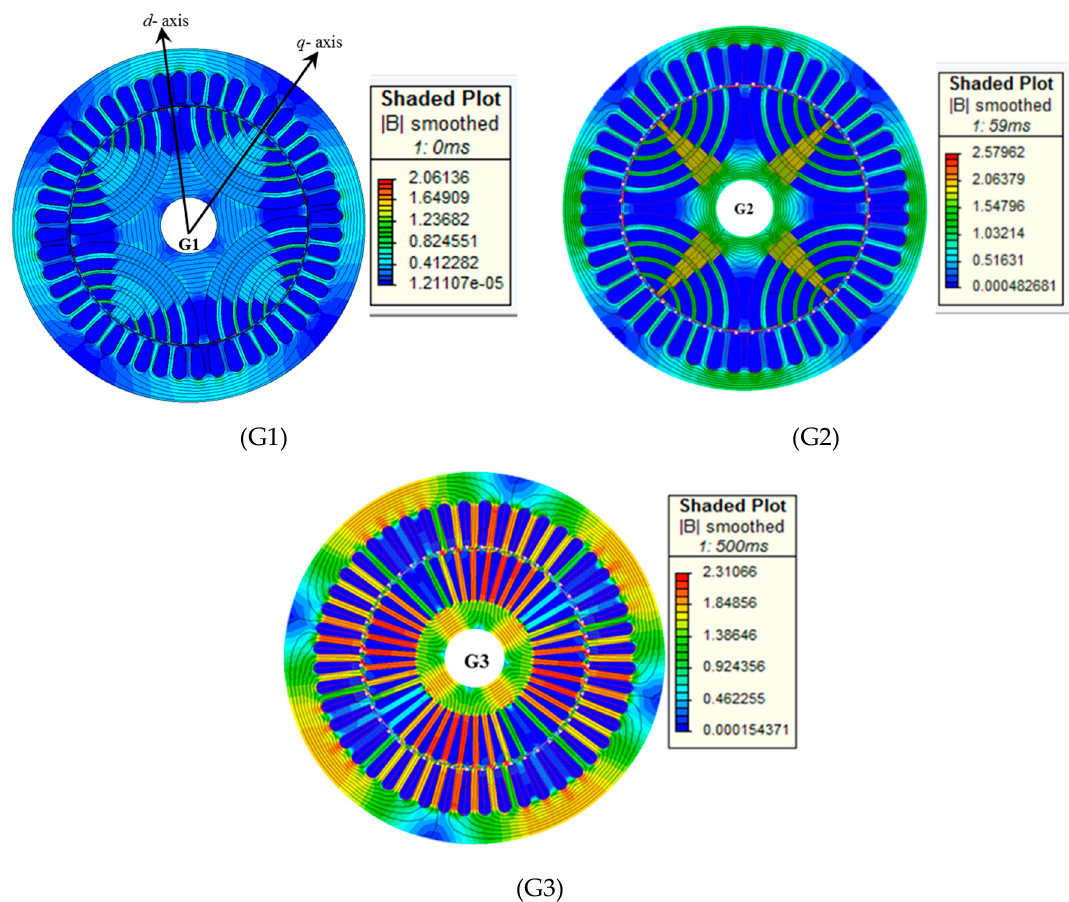
Figure 6. Flux density plot for G1, G2, and G3.